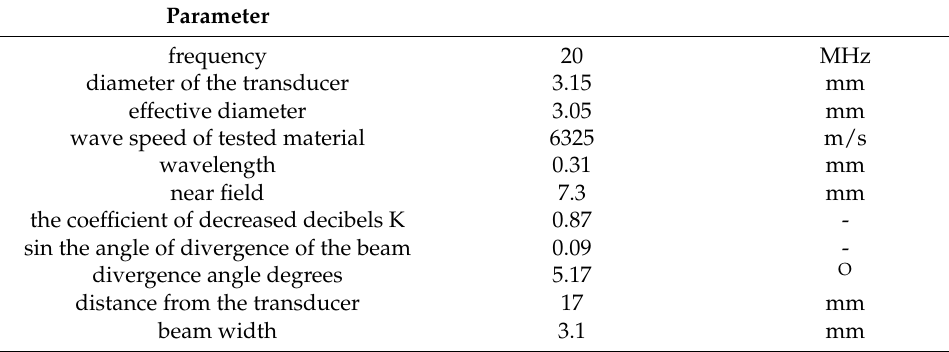
Table 3. Parameters of the ultrasound transducer used.